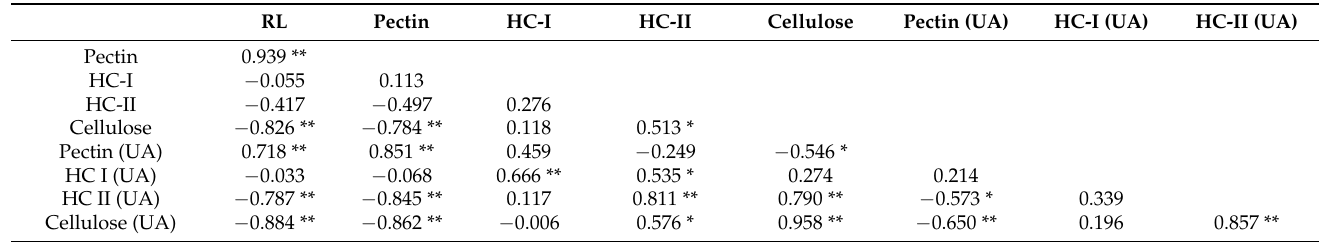
Table 3. Cross-correlation coefficients of final root length (RL); total sugar content of pectin, hemi- cellulose I (HC-I), hemicellulose II (HC-II), and cellulose; uronic acid (UA) content of pectin, HC-I, HC-II, and cellulose in the 0–5 mm region of apical root cap in S. oleracea . RL Pectin